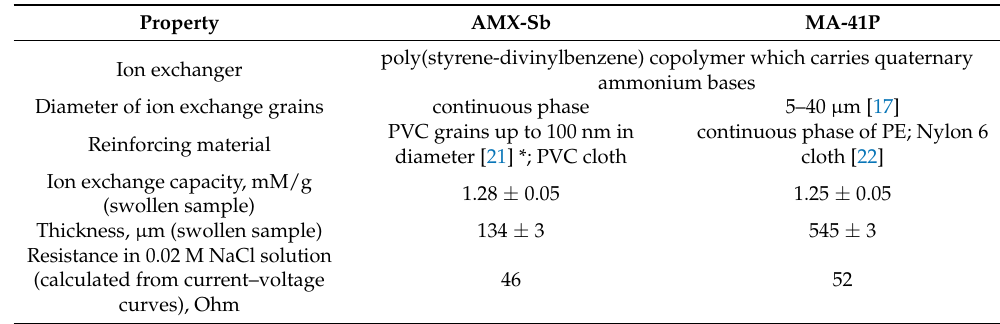
Table 1. Properties of AMX-Sb and MA-41P commercial substrate membranes.